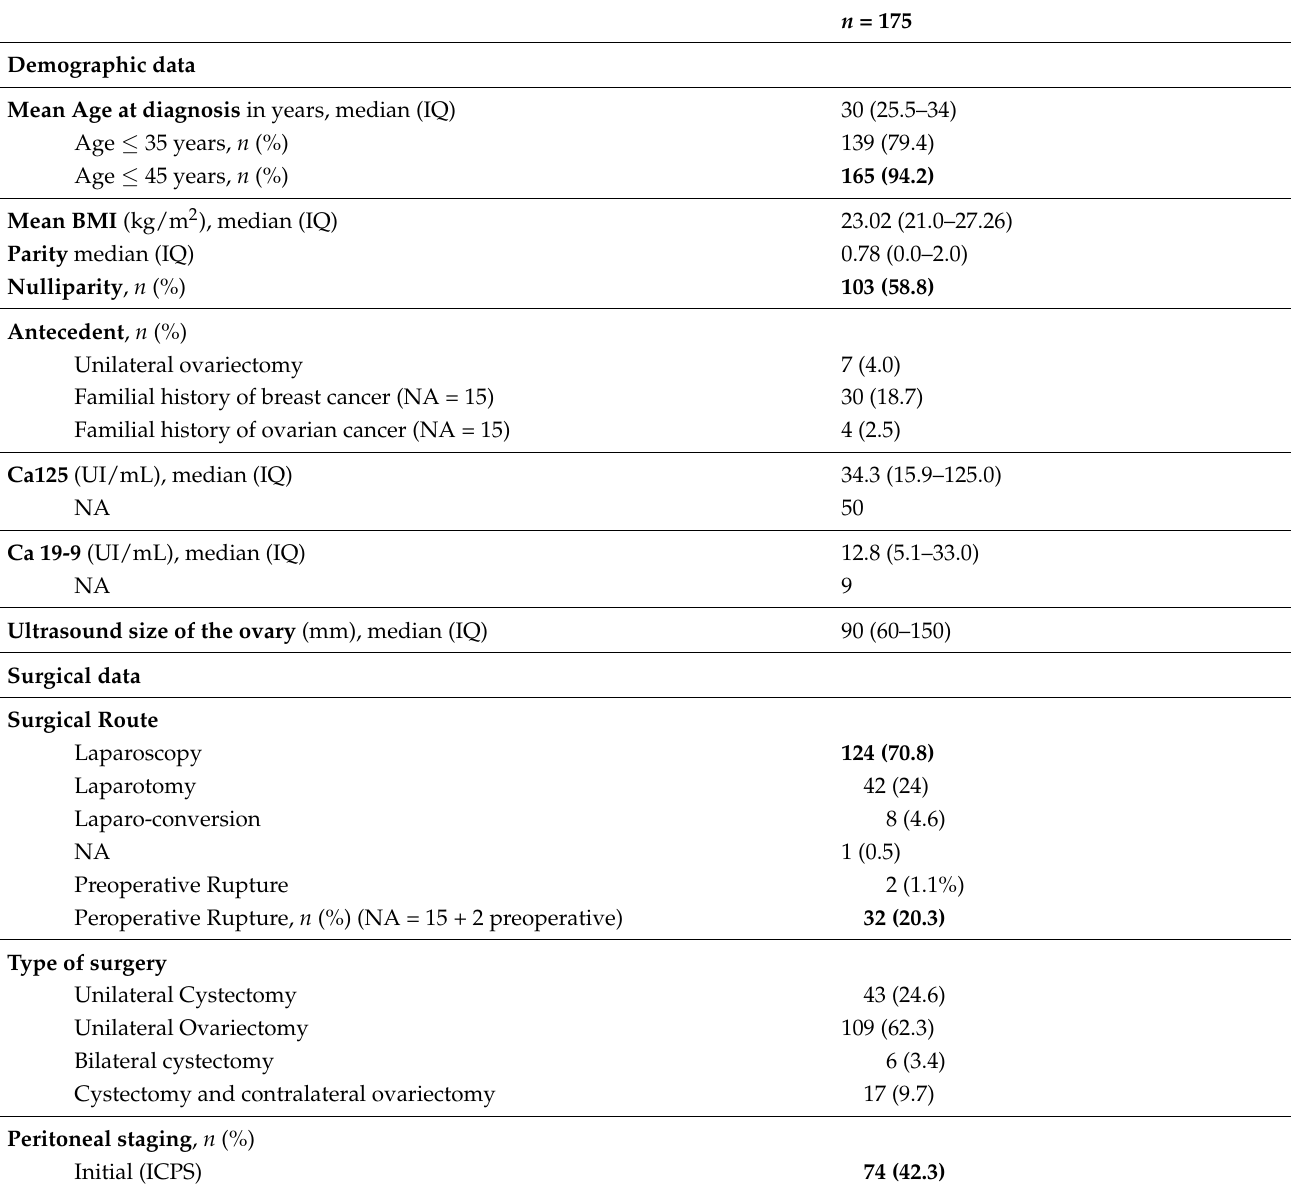
Table 1. Clinical, biological and surgical characteristics of the